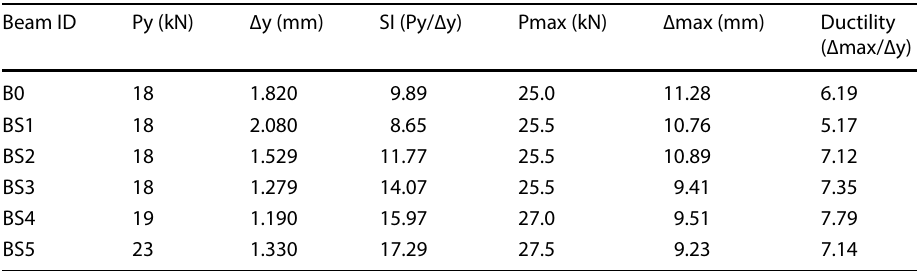
Table 4 Flexural performance parameters